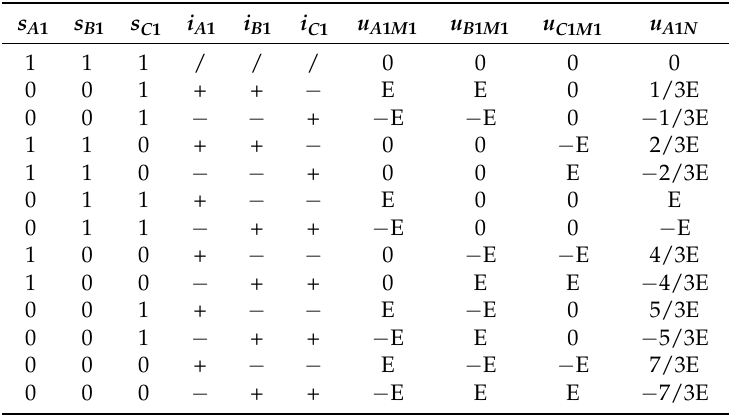
Table 2. The convert equivalent multilevel